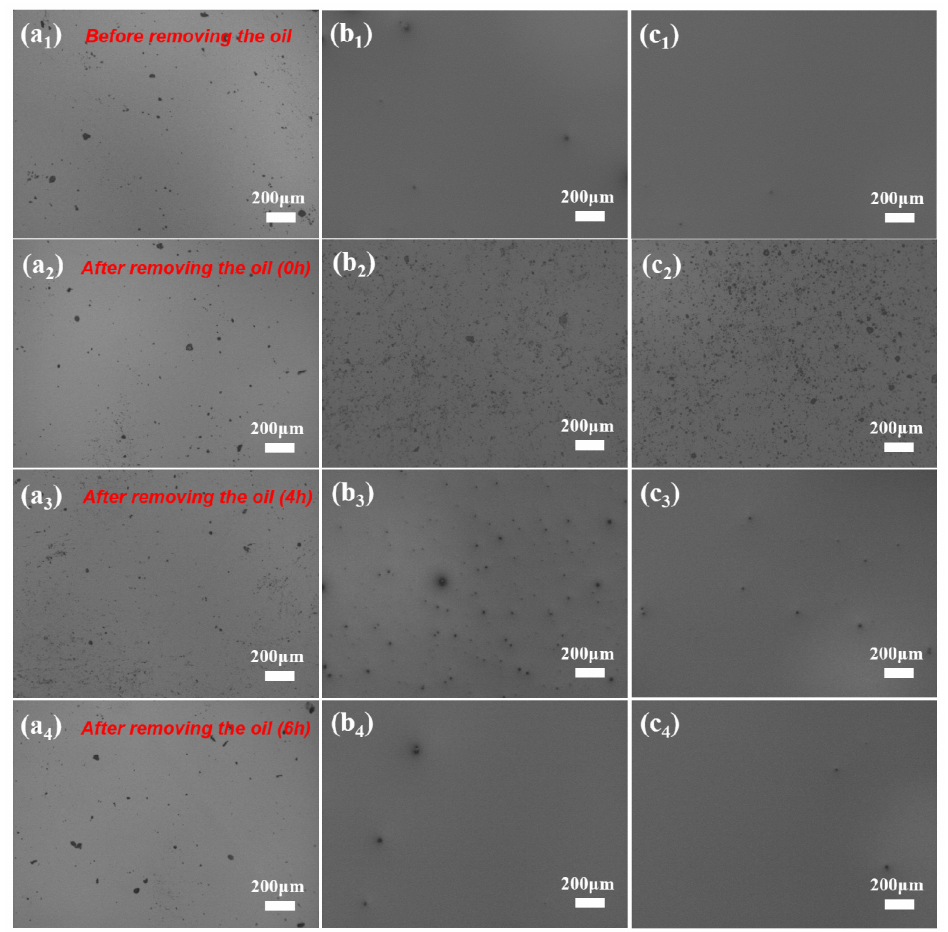
Figure 3. The oil replenishment processes of di ff erent sample surfaces: ( a 1 – a 4 ) pure sample, ( b 1 – b 4 ) 1P1S sample, and ( c 1 – c 4 ) 1P2S